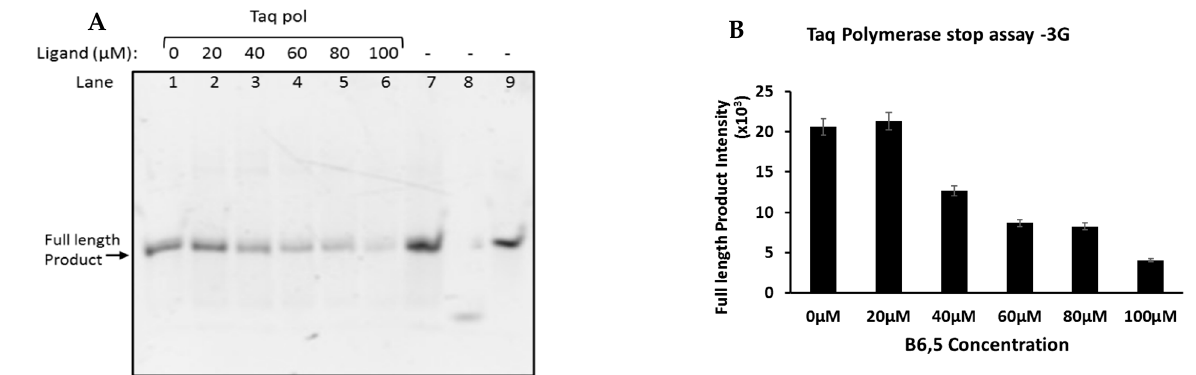
Figure 3. ( A ) Taq Polymerase stop assay of 3G DNA sequence analyzed using 15% denaturing PAGE in presence of 0 to 100 µM of ligand B6,5. (Lane: 1–6) The ligand concentration and polymerase addition is as indicated in the gel image. The band in lane 7 represents template-primer in buffer without polymerase and ligand as a control. The bands in lanes 8 and 9 represent primer and template respectively. The incubation time for Taq polymerase was 1 h at 40 °C. ( B ) On the right hand side is the graphical representation of band intensity (lane 1–6) analyzed using ImageJ software. The error bar indicates the group error obtained on analyzing three consecutive gels having same sample set.